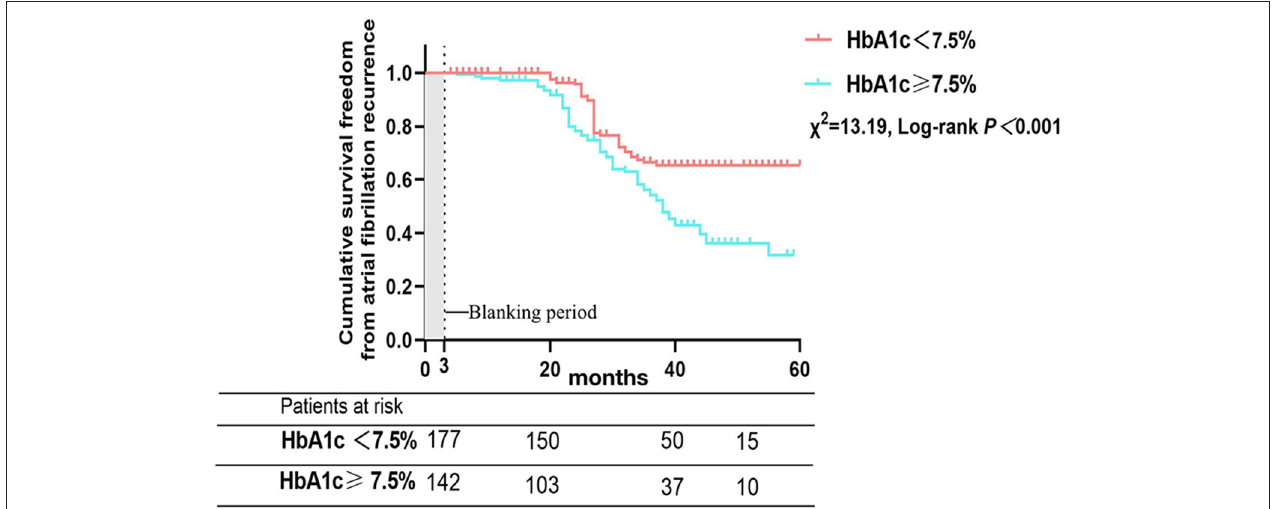
FIGURE 3 | Atrial fibrillation recurrence rates after Cox-Maze IV ablation according to glycated hemoglobin at the time of operation.